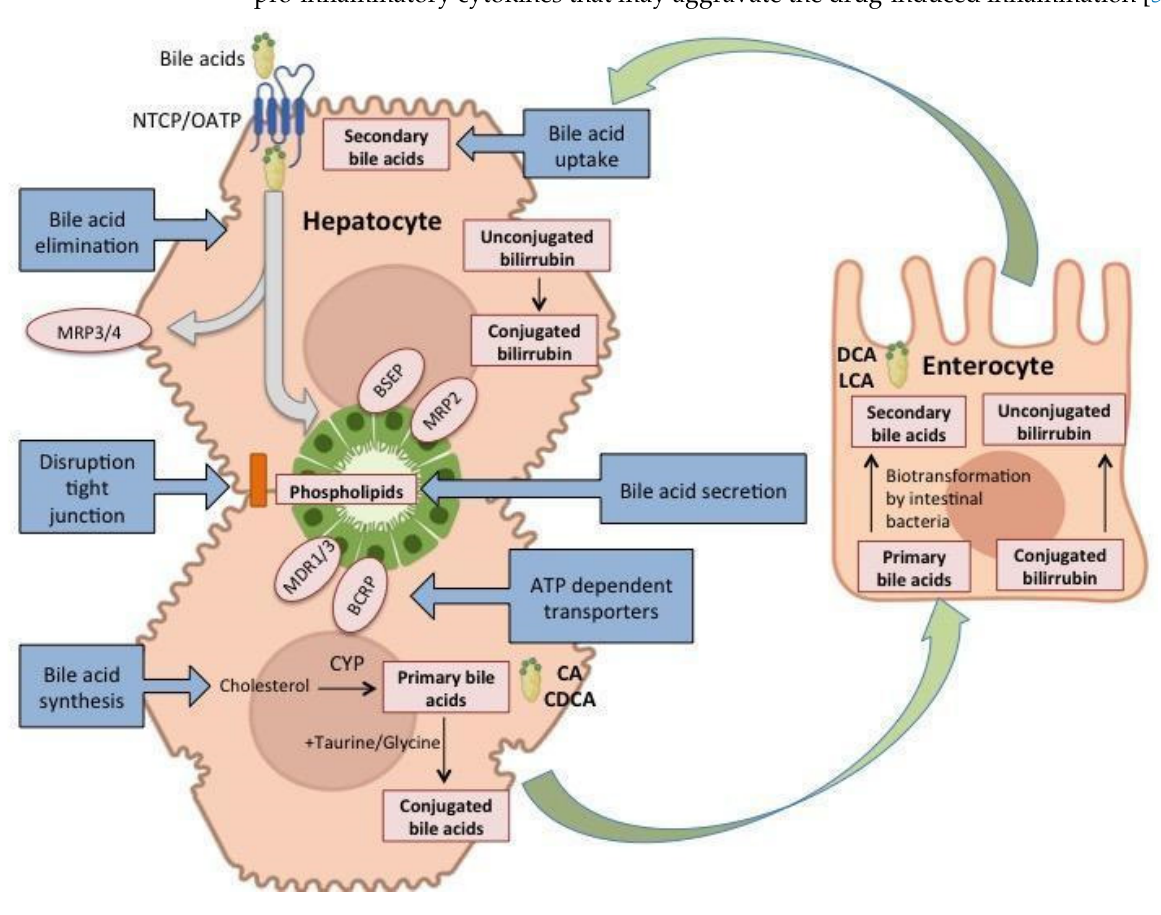
Figure 2. Schematic representation of the biochemical mechanisms in drug-induced cholestasis. Primary bile acids cholic and chenodeoxycholic acid are synthesized by hepatocytes, conjugated with taurine, glycine, and sulphate, and excreted into bile, reaching the intestine. There, the bacterial flora modifies them, de-conjugating and oxidizing to deoxycholic and lithocholic acid which is reabsorbed into blood, uptake by hepatocytes and conjugated again. There are ca. 40 different bile acid species in humans that can be properly analysed by metabolomics [49] and help to discriminate among the different causes of cholestasis.